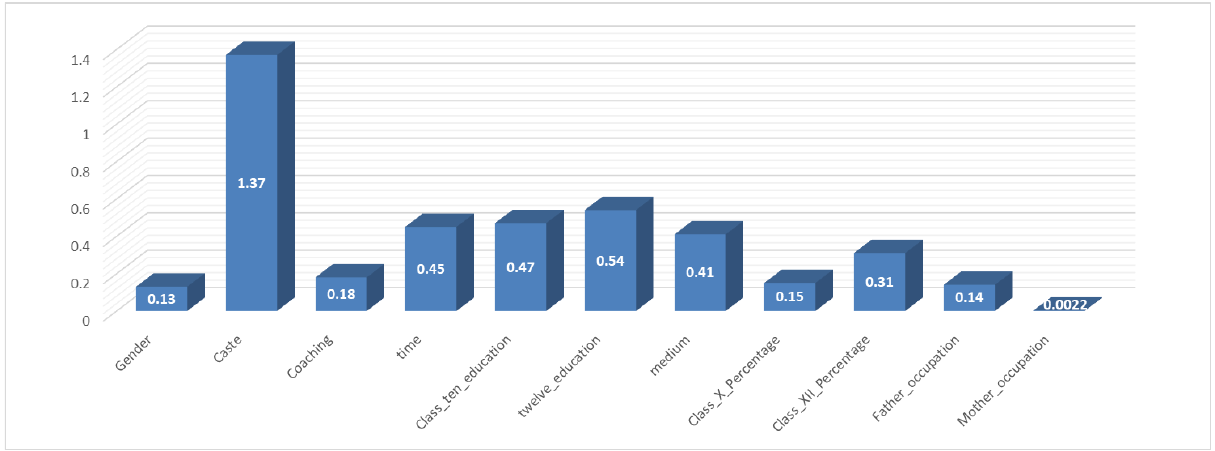
Figure 5. ATE value of the intervention variables.